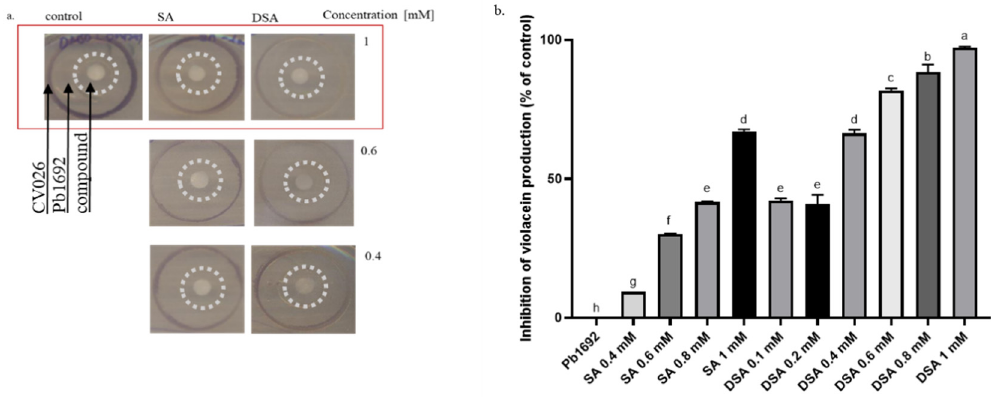
Figure 5. Effects of DSA and SA on the production of quorum sensing (QS)-signaling molecules (AHLs) by Pectobacterium brasiliense Pb1692. ( a ) Violet pigment (violacein) formed by Chromobacterium violaceum CV026 in response to N-acyl-homoserine lactones (AHLs) produced by Pb1692 grown in the presence of non-inhibitory concentrations of DSA or SA or DDW (control). ( b ) Violacein production by CV026 was measured as absorbance at 550 nm and is presented in terms of its inhibition relative to control (%). Bars represent means ± SE of 8 replicates per treatment. Data from one representative experiment of two independent experiments with similar results are presented. Bars that are labelled with the same letters are not significantly different from one another ( p < 0.05). One-way ANOVA and post hoc Tukey-Kramer HSD tests were used to analyze differences. The analysis was performed using GraphPad Prism 8.0.